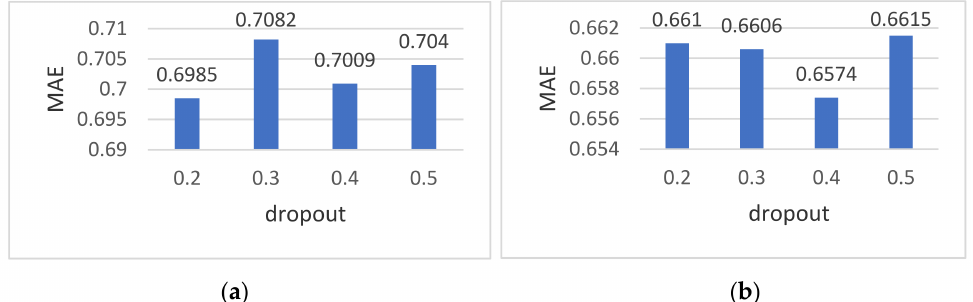
Figure 3. ( a ) Description of MAE values under different dropouts on the ML-100k dataset; ( b ) De- scription of MAE values under different dropouts on the ML-1m dataset.